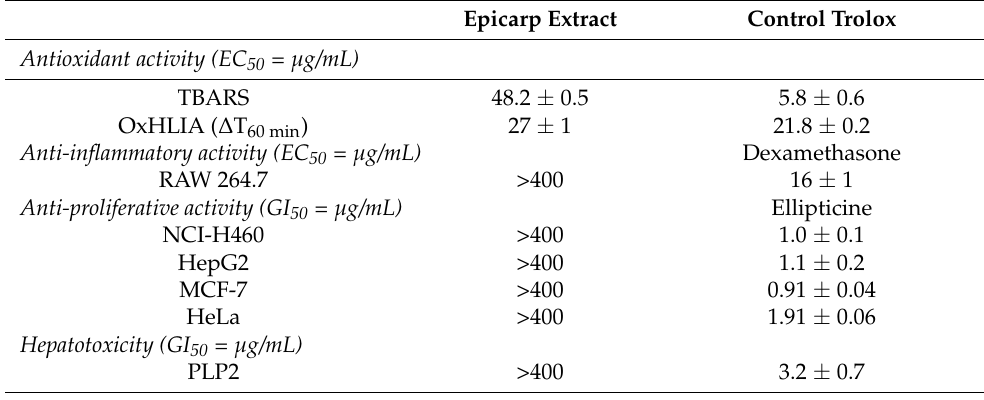
Table 3. Antioxidant, anti-inflammatory, and anti-proliferative activities of S. odorifera epicarp hydroethanolic extract. Epicarp Extract Control Trolox Antioxidant activity (EC 50 = µ g/mL) TBARS Anti-inflammatory activity (EC 50 = µ g/mL) Dexamethasone RAW 264.7 >400 16 ± 1 Anti-proliferative activity (GI 50 = µ g/mL) Ellipticine NCI-H460 >400 1.0 ± 0.1 HepG2 >400 1.1 ± 0.2 MCF-7 >400 0.91 ± 0.04 HeLa >400 1.91 ± 0.06 Hepatotoxicity (GI 50 = µ